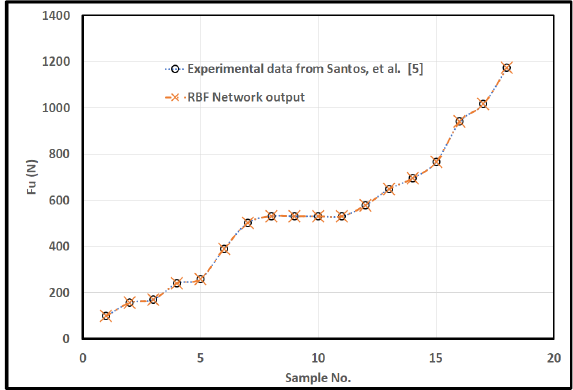
Fig. 8. The computed from the networks outputs & Q against the experimental data from Santos, et al. [5] .